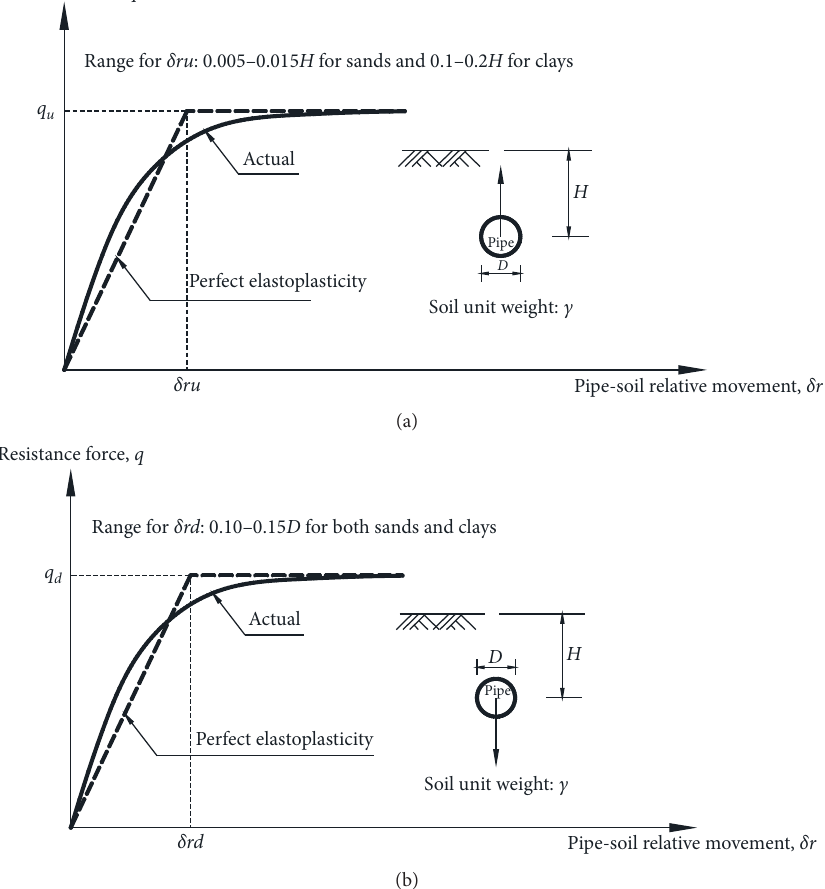
Figure 2: Force-displacement response of pipeline-soil interaction: (a) upward relative displacement; (b) downward relative displacement [24, 25].